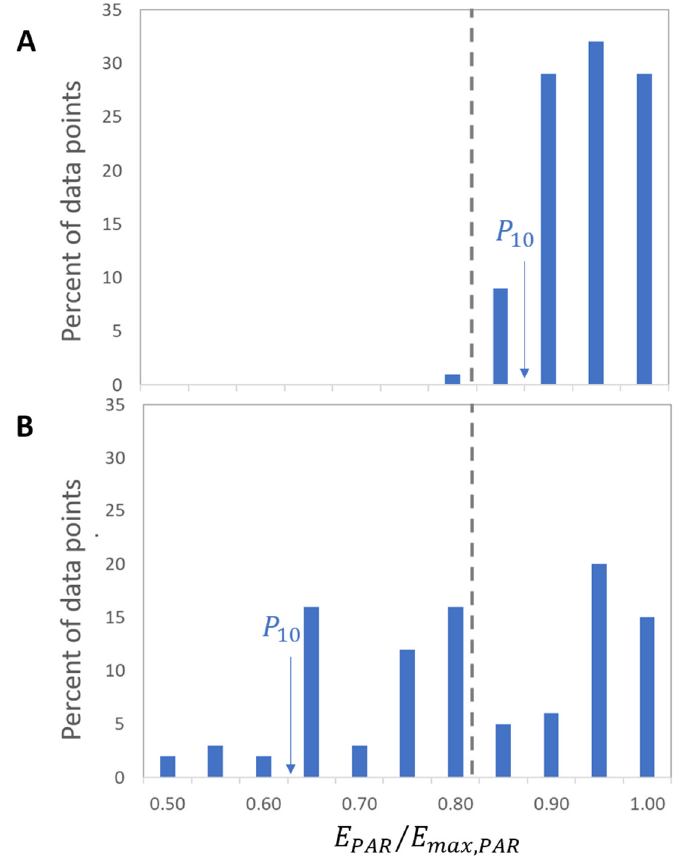
Figure 4. Histogram of relative photosynthetic photon irradiance (PPFD) values for illumination settings (A),(B). The labels on the horizontal axis are the upper bounds of the corresponding bins. The arrows indicate the 10th percentile ( P10 ) of the data set. The dotted line represents a hypothetical specification limit. The width of the PPFD distribution is narrower in ( A ) compared to ( B ) in line with the contour plots in Figure